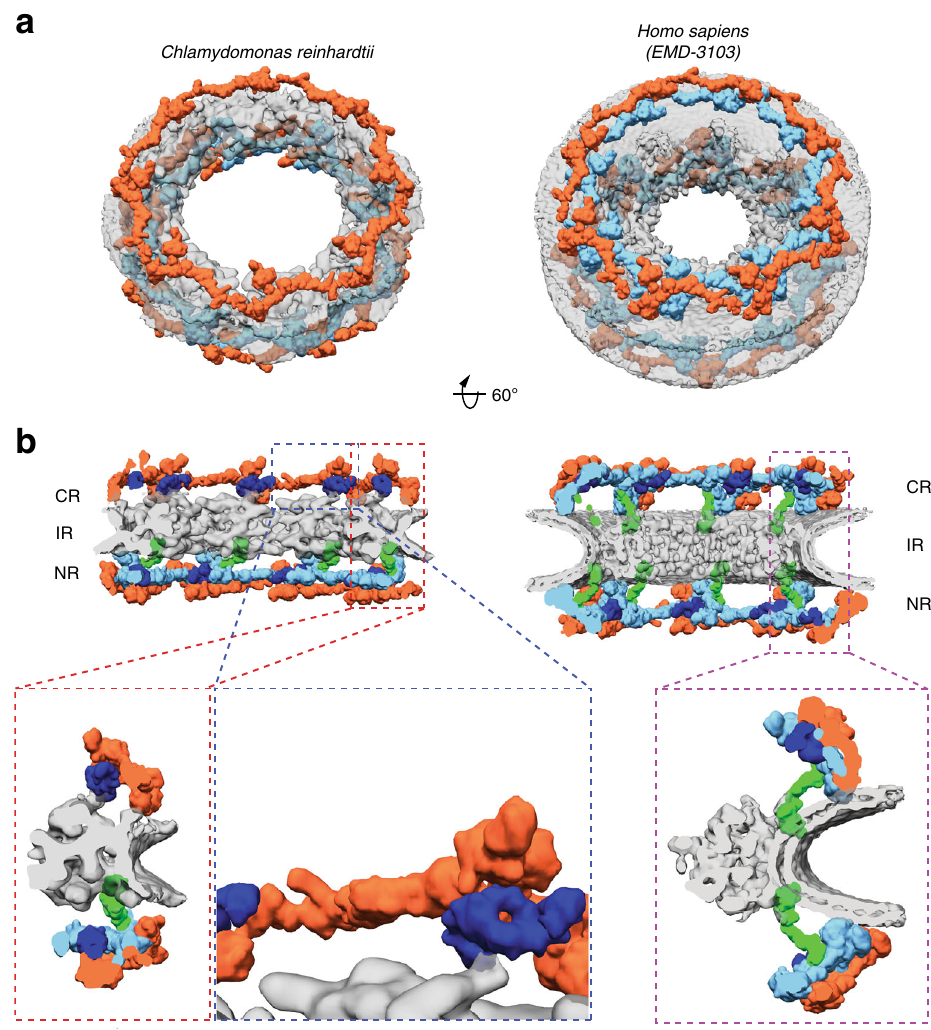
Fig. 3 The Cr NPC has 24 Y-complexes. a Segmented Y-complexes according to the fi ts presented in Supplementary Figs. 6, 8, and 9 are shown superimposed with the inner ring structure (gray). The distribution of Y-complexes in the Cr NPC is asymmetric across the nuclear envelope plane. The cytoplasmic ring has only eight Y-complexes (orange), whereas the nuclear ring has 16 (orange and light blue). In the Hs NPC, the distribution is symmetric, with 16 Y-complexes in both of the outer rings. b Rotated views of the Cr NPC and Hs NPC, sliced through the central axis. Density attributed to large scaffold Nups (Nup205/Nup188) in the outer rings of the Hs NPC (dark blue) is found between the inner (light blue) and outer (orange) copies of the Y-complexes. Similar density is observed in the Cr NPC, although this assignment remains tentative at the given resolution. Enlarged views on the bottom row show the presence of only one connector element (green) in the Cr NPC (red box), with the cytoplasmic ring lacking the connector (blue box), while the Hs NPC contains two connector elements and duplicated Y-complexes (purple box). CR cytoplasmic ring, IR inner ring, and NR nuclear